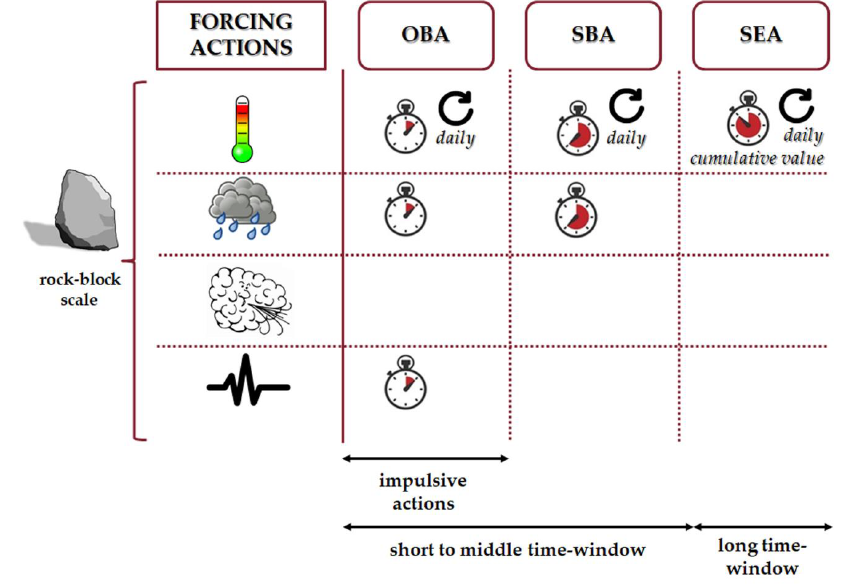
Figure 14. Summary table showing the applicability of the proposed approaches for detecting factors influencing the rock mass stability at the Acuto test-site. The clocks indicate the time windows (i.e., from short- to long-term) over which specific factors are e ff ective. The loop arrows indicate that the considered processes are